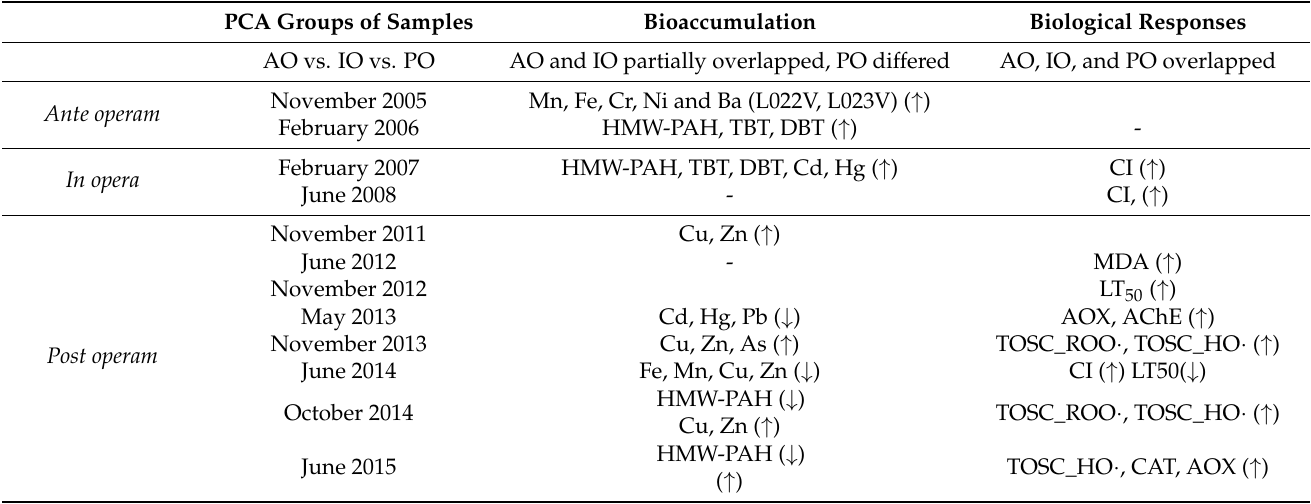
Table 1. Results of visual correlation between PCA biplots of Figures 2 and